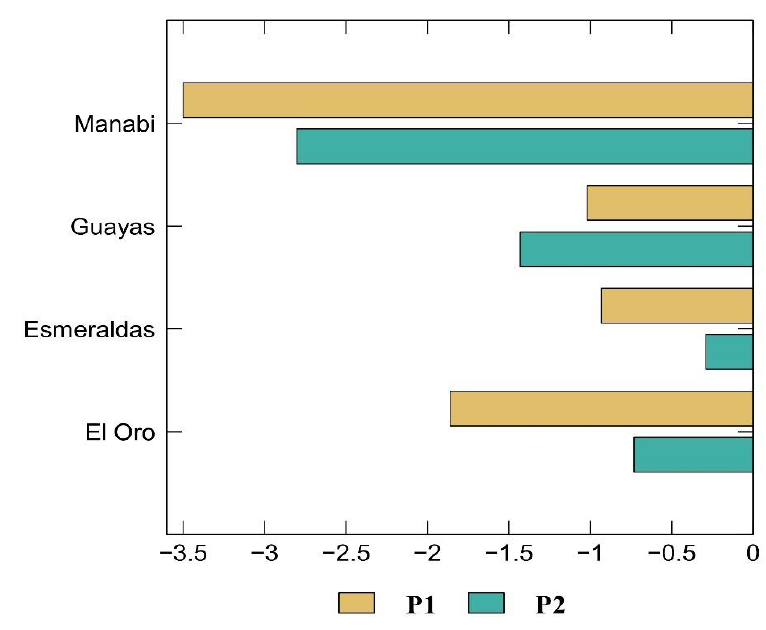
Figure 6. Mangrove loss rates by province. P1: 1998 – 2010, P2: 2010 – 2018.